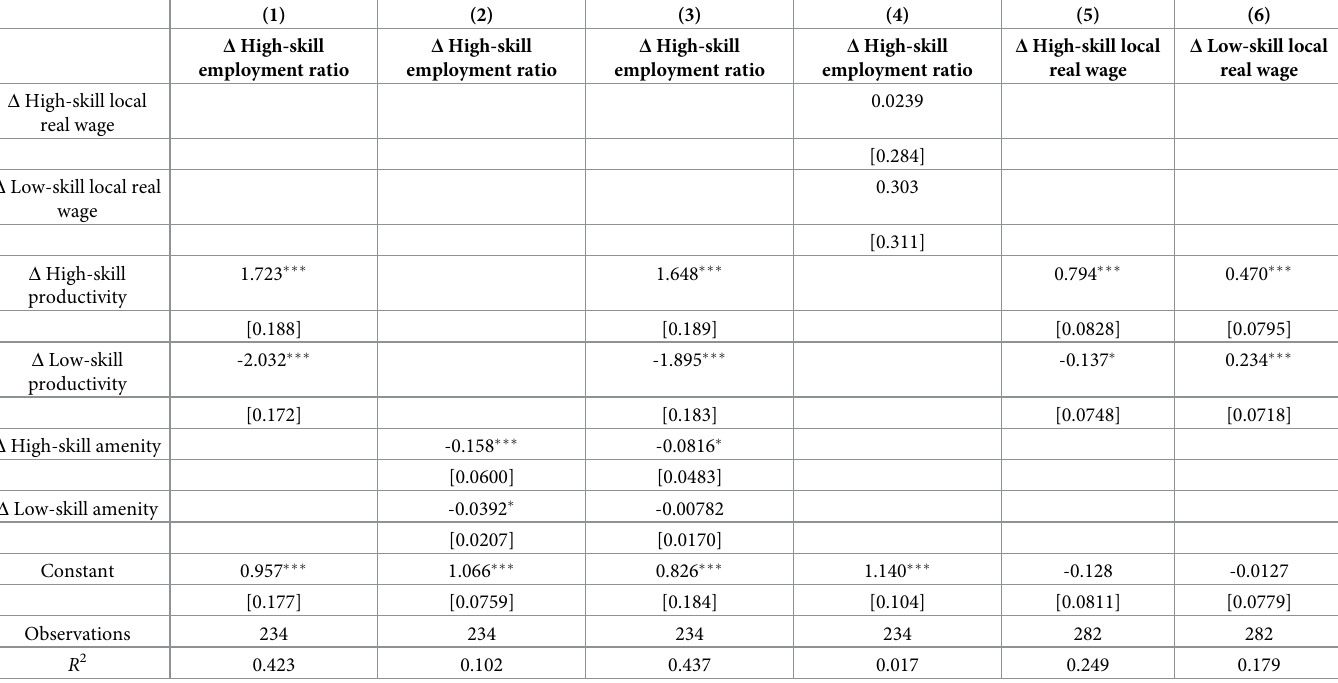
Table 8. Reduced-form relationship between high-skill employment ratio, local real wages, and local employment